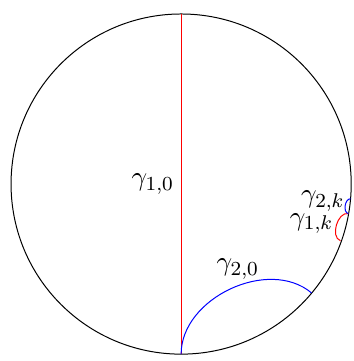
Figure 10 . The representative geodesics γ 1 , 0 , γ 2 , 0 , γ 1 ,k and γ 2 ,k from figure 9 are shown after applying an AdS 3 isometry to move γ 1 , 0 into the standard position along the φ